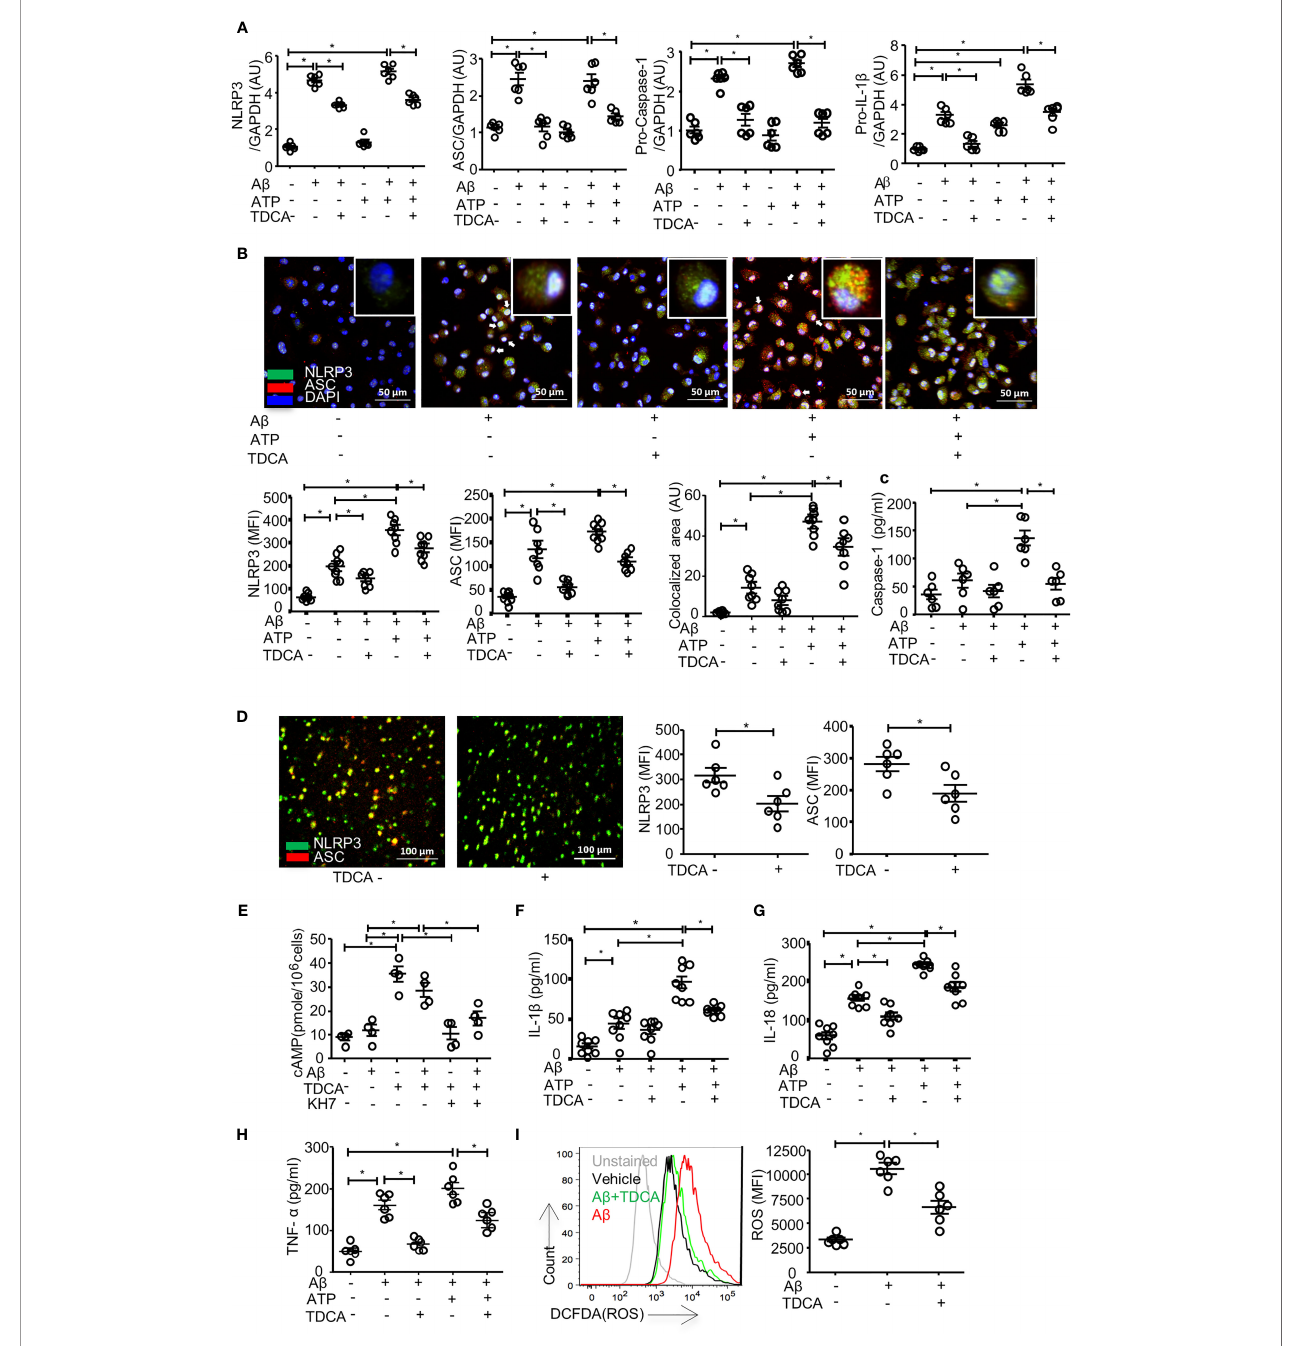
FIGURE 3 | TDCA suppresses activation of the NLRP3 in fl ammasome and inhibits the production of IL-1 b , IL-18, TNF- a , and ROS in microglia. (A) , Transcripts of NLRP3, ASC, pro-caspase-1 , and IL-1 b in BV2 cells were quantitated using qPCR after treatment with A b , TDCA, and ATP. Gene expression was normalized using GAPDH. (B) , The expression of NLRP3 (green) and ASC (red) in primary microglia was determined using confocal microscopy. Nuclei were stained with DAPI (blue). Colocalization of NLRP3 and ASC (yellow) was analyzed using ImageJ. (C) , Concentrations of caspase-1 in culture supernatants of primary microglial cells were analyzed using ELISA. (D) , 5xFAD mice (n = 6/group) were treated with 1 mg/kg TDCA i.p. for 10 weeks, and the expression levels of NLRP3 (green) and ASC (red) in the frontal cortex were analyzed using confocal microscopy. (E) , The level of cAMP in the BV2 cell lysates was measured. BV2 cells were also cultured in the presence of the adenylate cyclase inhibitor KH7 (4 µM). IL-1 b (F) , IL-18 (G) , and TNF- a (H) in the culture supernatants of BV2 cells were analyzed using ELISA. (I) , ROS production in BV2 cells was quantitated using FACS after pulsing cells with DCFDA. A representative FACS plot (left panel) of three independent experiments (right panel) is depicted. The individual samples are shown with the mean ± SEM and *P < 0.05 using Student ’ s unpaired